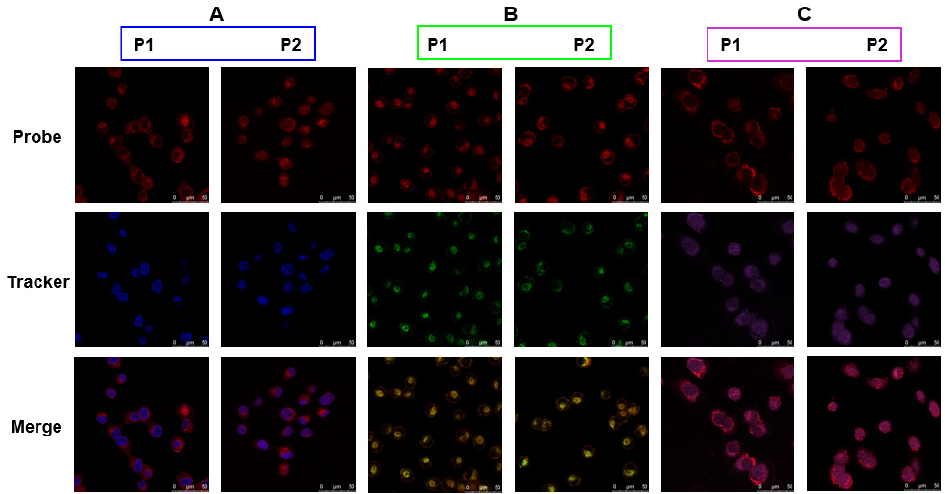
Figure 5. Probes colocalized imaging. P1 – P2 (10 µ M) with nuclear dye DAPI (blue) ( A ), mitochon- drial dye Mito-Tracker (green) ( B ), and ER β secondary antibody dye (purple) ( C ), respectively, in DU-145 cells.